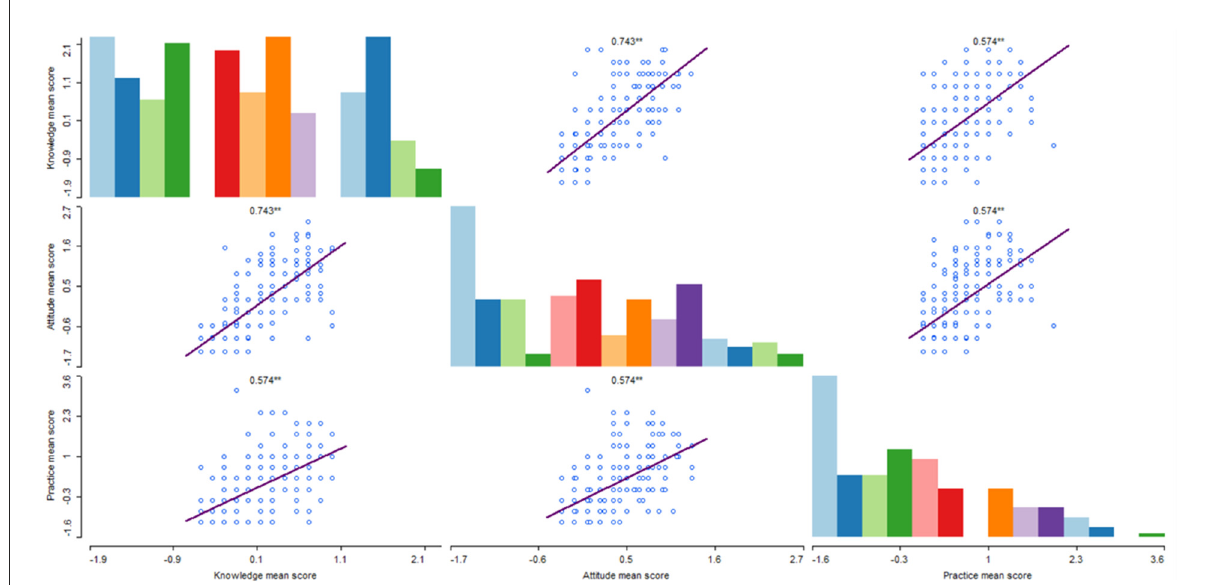
FIGURE8 Correlation matrix which show the relationship of KAP score among smallholder farmers in